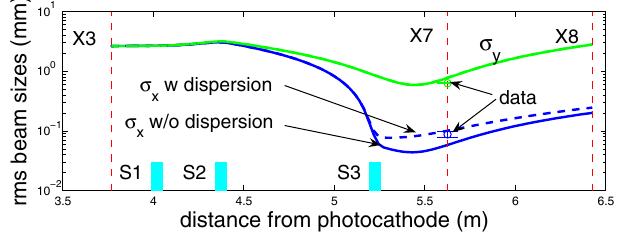
FIG. 5. (Color) Evolution of the transverse beam rms sizes along the transformer with (solid lines) and without (dash lines) the contribution of spurious dispersion. The circles correspond to the horizontal (blue) and vertical (green) measured beam sizes (see Table III). The vertical dash lines and the filled boxes, respec- tively, represent the viewer and skew quadrupole